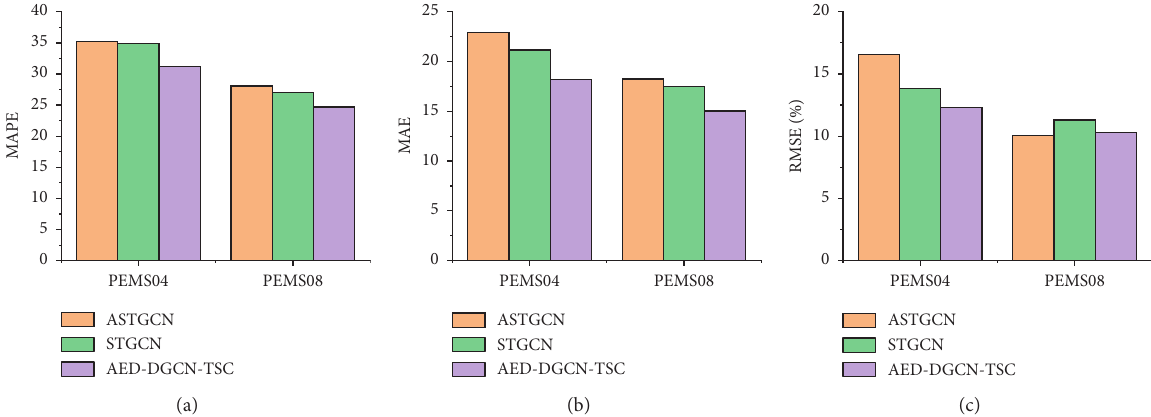
Figure 11: Comparison of the performance of ASTGCN, STGCN, and AED-DGCN-TSC with two datasets. (a) Comparison of MAE. (b) Comparison of RMSE. (c) Comparison of